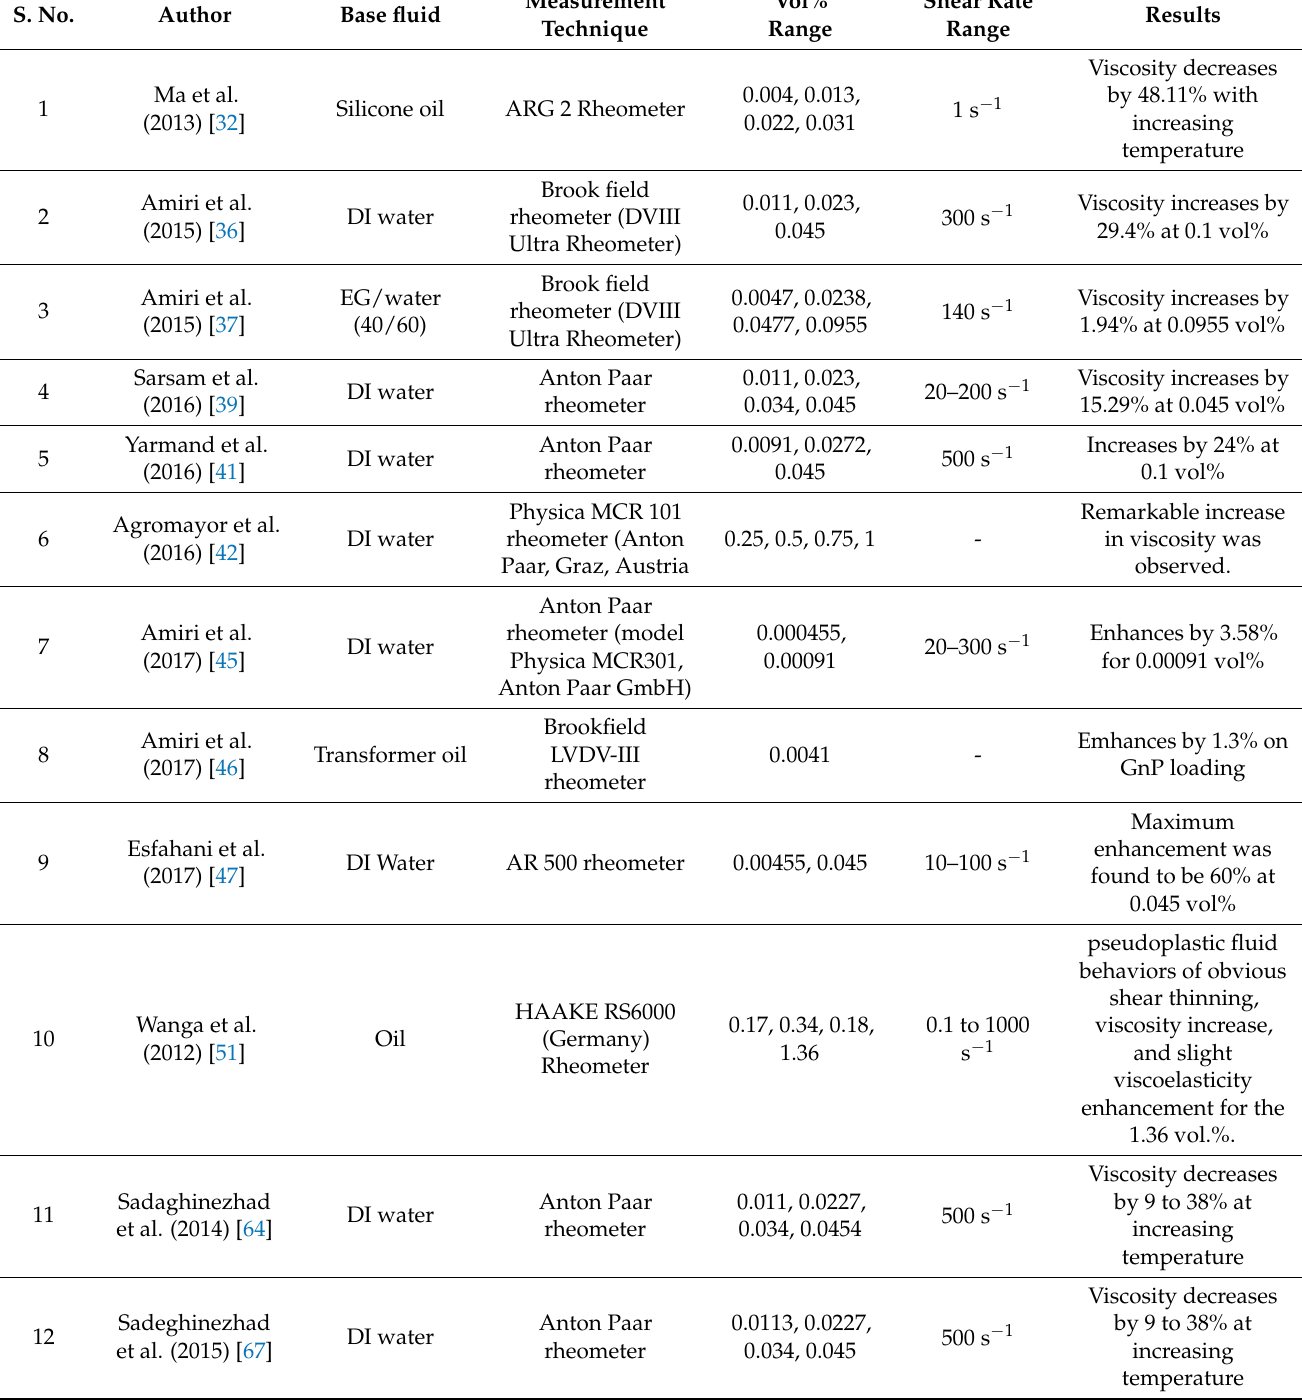
Table 9. Summary of published literature on rheological characteristics of graphene-based